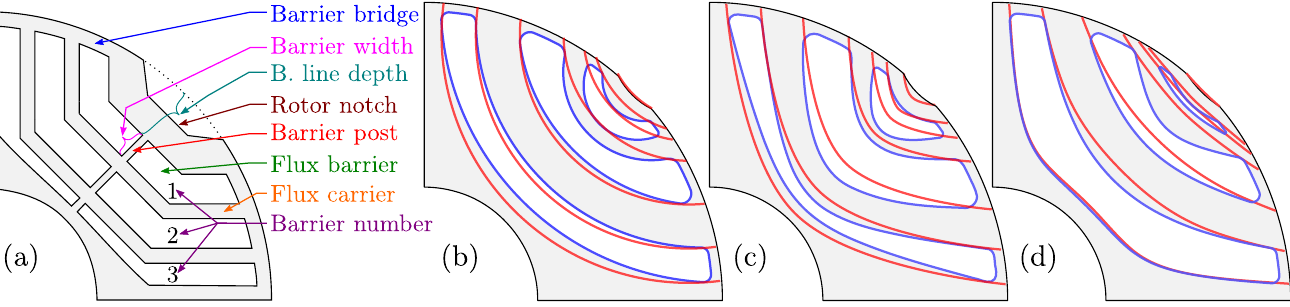
Figure 2. ( a ) SyRM terminology; SyRM rotor barrier types: ( b ) Circular variable depth (blue), concentric (red); ( c ) Hyperbolic variable eccentricity (blue), fixed eccentricity (red); ( d ) Modified Zhukovsky (blue), original Zhukovsky